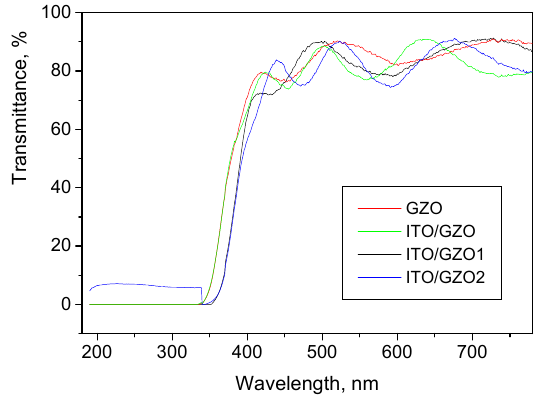
Figure 4. Optical transmittance in the UV-VIS range of single layer of GZO and bi-layer coatings ITO/GZO without and with additional oxidation during sputtering [31].